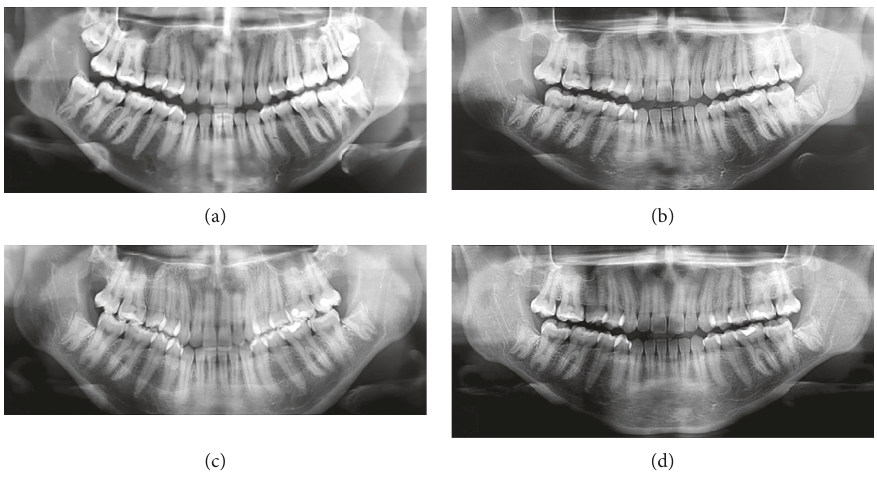
Figure 1: (a) Initial panoramic radiograph and (b–d) follow-up with 7 days, 6, and 12 months,